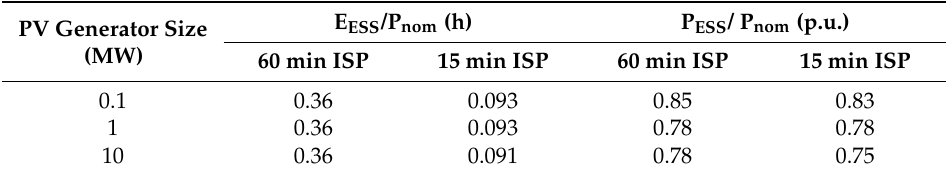
Table 1. ESS energy and power capacity requirements with respect to the PV plant nominal power for compensating the output powers of the studied PV generators for 15 and 60 min ISP on the electricity markets.